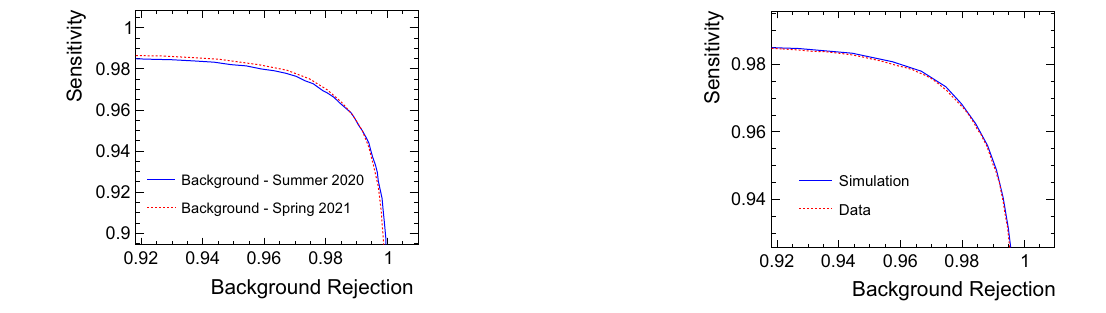
Fig. 12 ROC curves for simulated and real beam background. In both cases, the same signal set is used